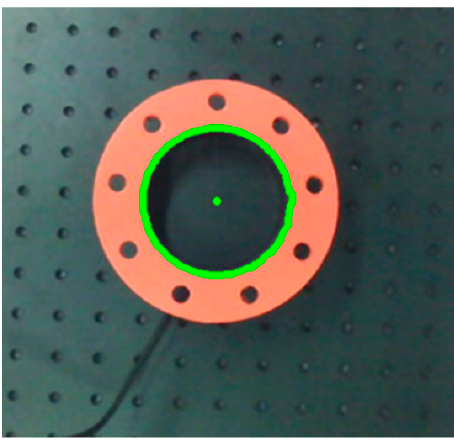
Figure 8. Schematic diagram of the image depth calculation. Table 2. Parameters of the camera.